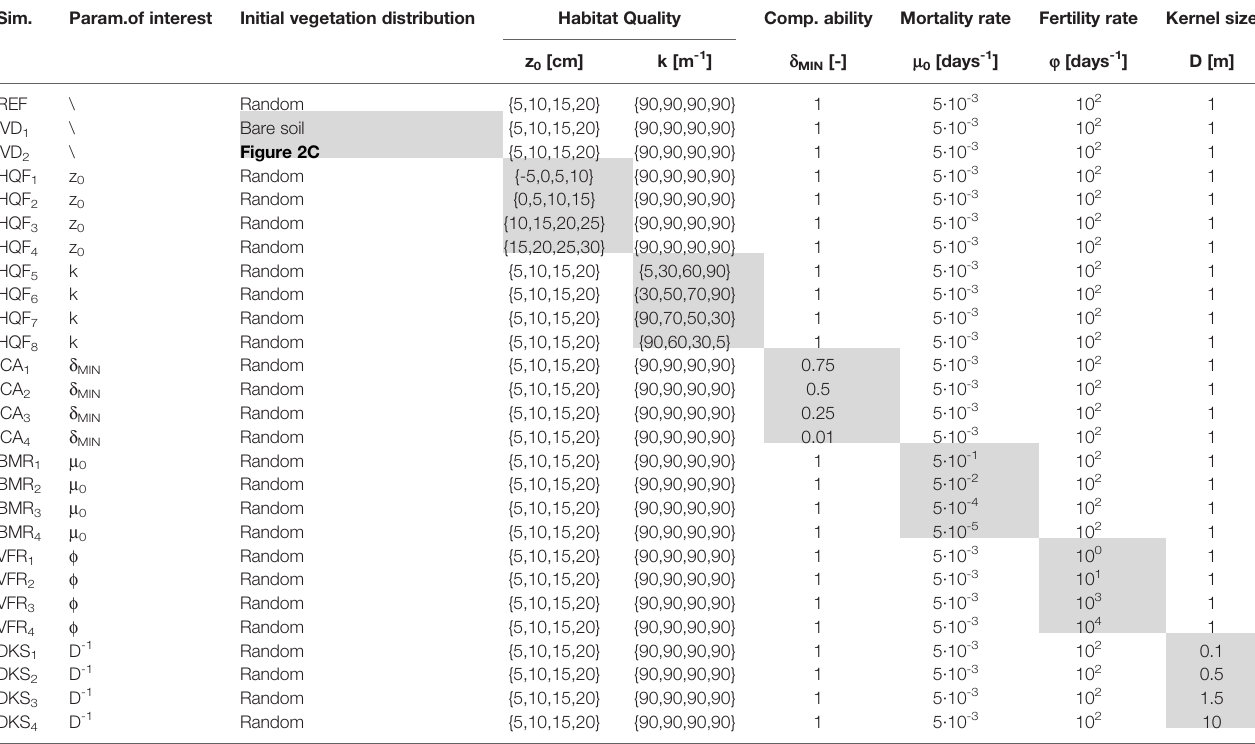
Gray shading denotes the parameter of interest for each